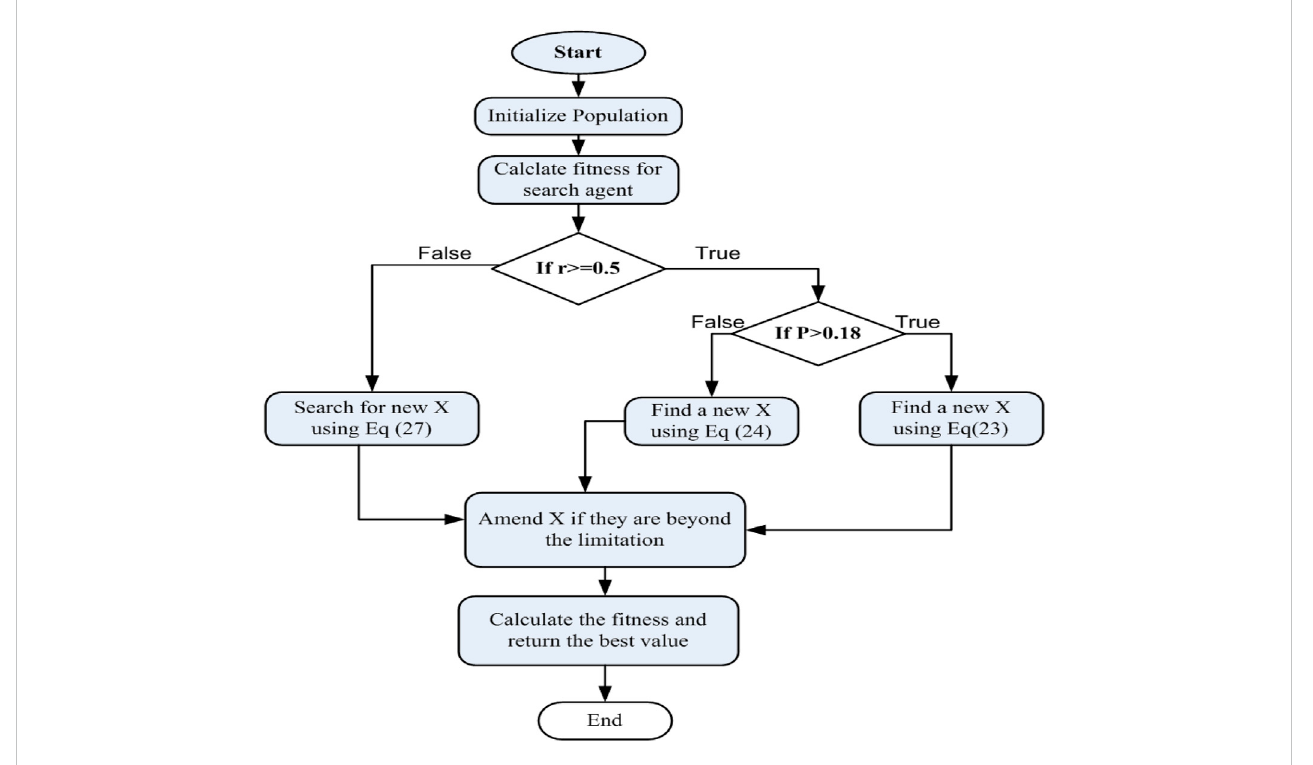
FIGURE 4 Flow chart of Fox Optimizer